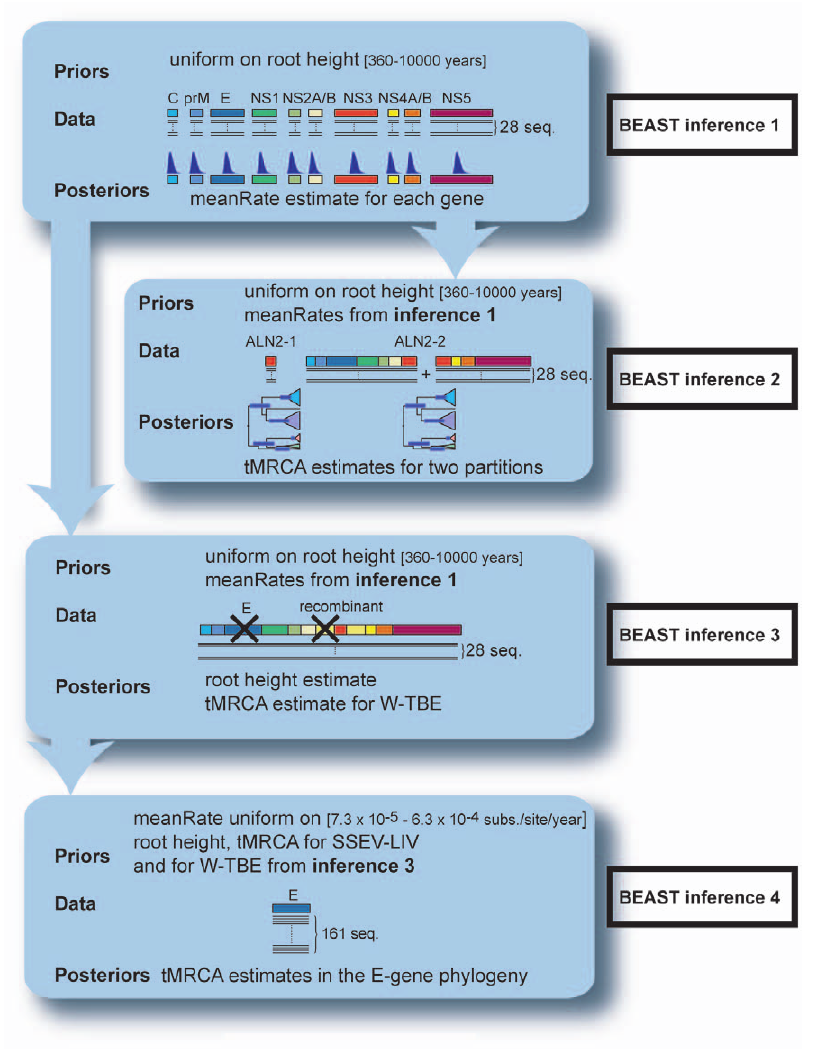
Figure 1. Analytical framework for the BEAST analyses. Inference 1 analyses the variation in substitution rates across the genome for the 28 full length ORFs. The inferred posterior probability distributions of meanRates for individual genes are set as priors for inferences 2 and 3. Inference 2 dates the recombination event based on the 28 full length ORFs. Dates are evaluated separately for the recombinant region and for the non- recombinant sequences. Inference 3 gathers priors information for root height, tMRCA(W-TBE) and tMRCA(LIV & SSEV) used for the next inference. The alignment for inference 3contains the same 28 sequences, with the deletion of E-gene and the recombinant region. Inference 4 refines estimates for tMRCA(W-TBEV) based on 161 E-sequences. Prior distribution for meanRate parameter is derived from the literature. Priors for tMRCA(W-TBEV) and tMRCA(LIV & SSEV) were obtained from BEAST inference 3.